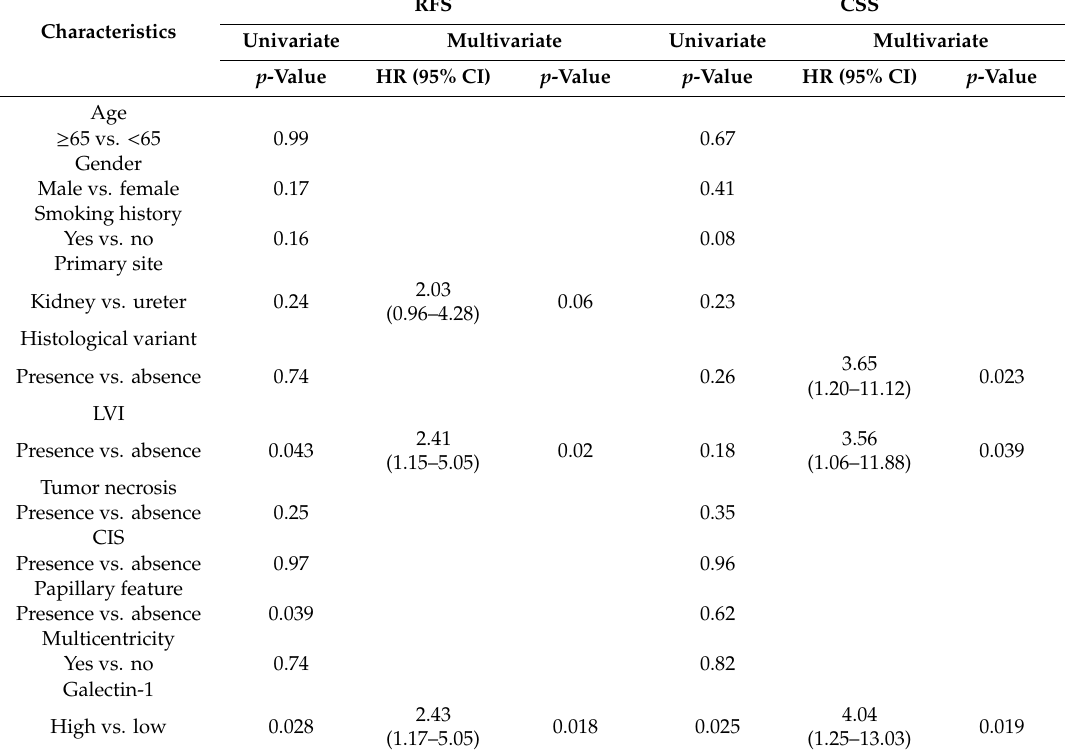
Table 2. Univariate and multivariate analyses of RFS and